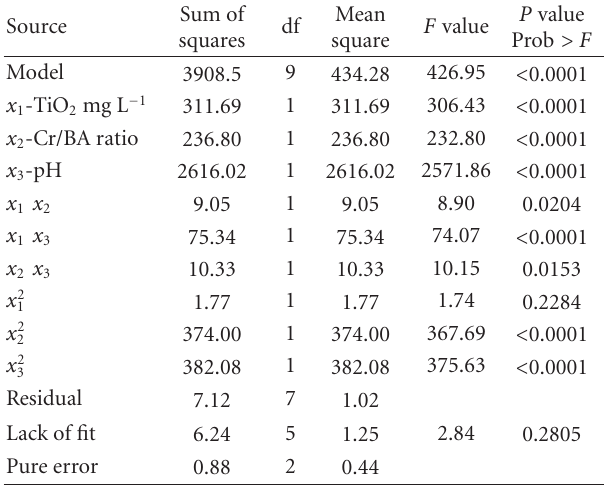
Table 2: Analysis of variance (ANOVA) for % removal of Cr(VI). Source